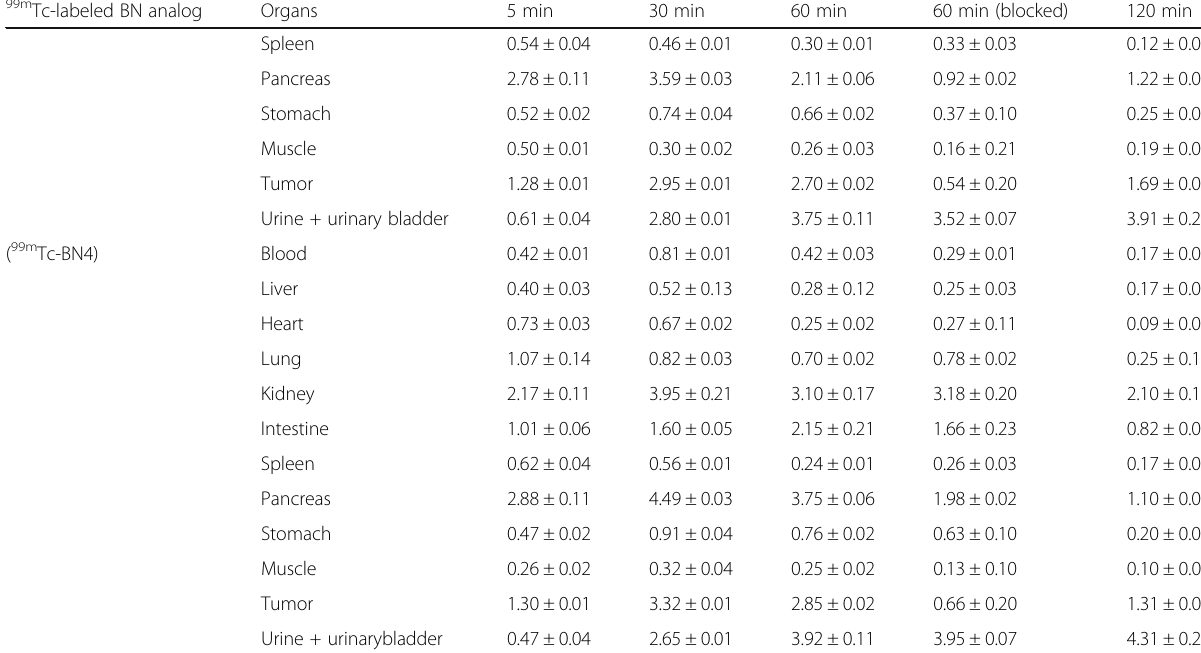
Table 2 Biodistribution data of the 99m Tc-labeled standard bombesin (BNS) and new bombesin analogs (BN1, BN2, BN3, BN4) in tumor-bearing mice at 5, 30, 60, and 120 min post-injection (PI). All the data represent %IA/g (mean ± SD) value and are the mean of results from three animals per time point